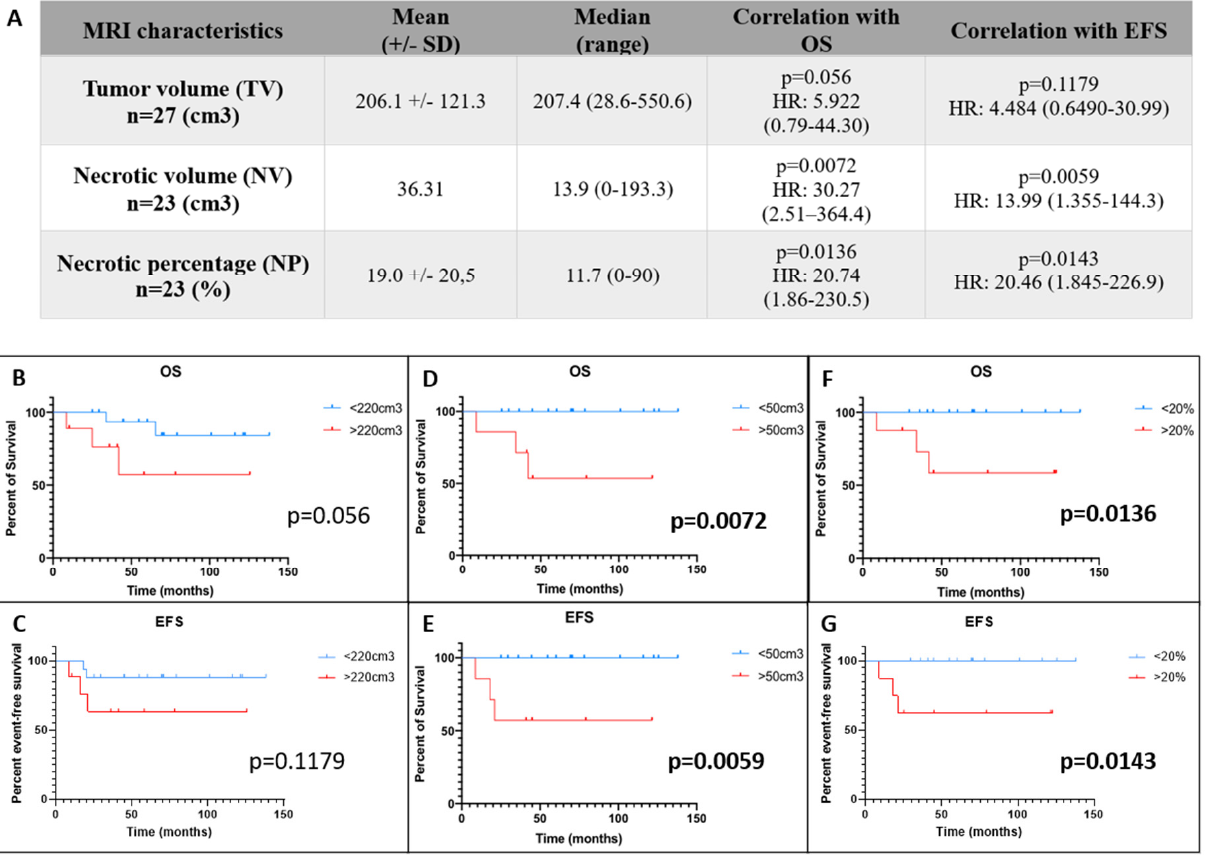
Figure 3. Radiological measures and their statistical correlations with survivals. ( A ) Table summa- rizing the MRI characteristics and the measures. ( B ) OS and ( C ) EFS distributions according to the entire tumor volume (TV) (optimal cutpoint at 220 cm 3 ). ( D , E ) Kaplan–Meier estimates of OS and EFS according to the tumor necrotic volume (NV) (optimal cutpoint at 50 cm 3 ). ( F , G ) Kaplan–Meier estimates of OS and EFS according to the optimal cutpoint for necrotic percentage (NP) (e.g., 20%). p values are reported on the right corner of the graphs, in bold when p < 0.05.